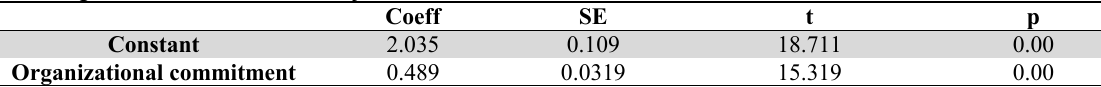
Effect of organizational commitment on job satisfaction